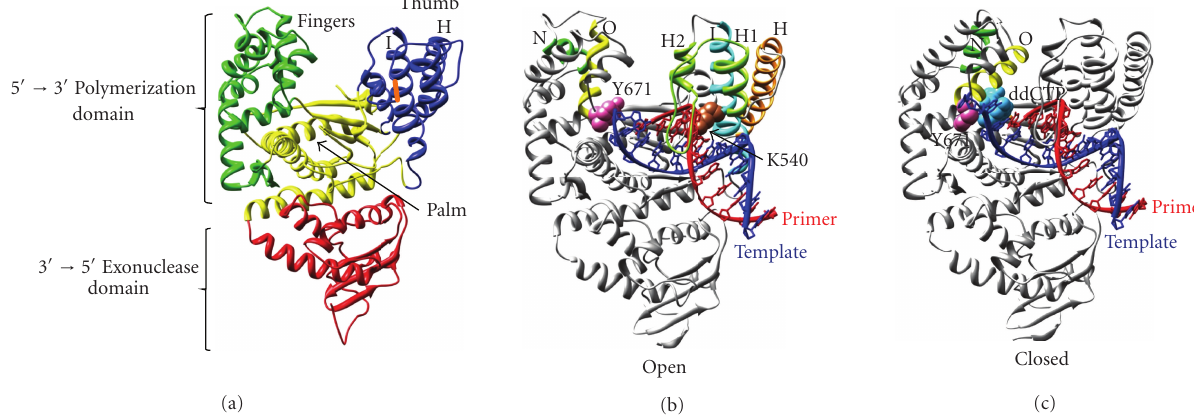
Figure 1: Structure of Klentaq1 (a) Structure of Klentaq1 in the absence of DNA (PDB #1KTQ) [7]. The overall structure of polymerases resembles that of a human right hand forming palm (yellow), fingers (green), and thumb (blue) domains. The palm domain houses the active site residues responsible for the 5 (cid:2) to 3 (cid:2) polymerase activity, and the 3 (cid:2) to 5 (cid:2) exonuclease domain (red) allows excision of misincorporated bases. The H1H2 Loop is disordered and missing from the structure (ends connected with orange line). (b) Klentaq1 open binary complex (PDB #4KTQ) [8]. The DNA is situated in the cleft formed between the fingers, thumb, and palm domains. The Y671 residue (pink) is stacked on top of the template (dark blue). K540 (brown) makes nonspecific interactions with the minor groove to aid in holding the polymerase bound to the DNA. Helices I (cyan) and H (orange) make small movements relative to their positions in the open complex, and the H1H2 loop (light green) now becomes ordered and visible in the structure. The remainder of the colors are as follows primer (red), H1 and H2 helix (light green), O helix (yellow), and N helix (green). (c) Klentaq1 closed ternary complex (PDB #3KTQ) [8]. A correctly base pairing ddCTP (light blue) is located within the active site inducing a large conformational change of the O (yellow) and N (green) helices (compare with positions in (b)). Y671 is now flipped out of its stacking arrangement with the template and the templating base